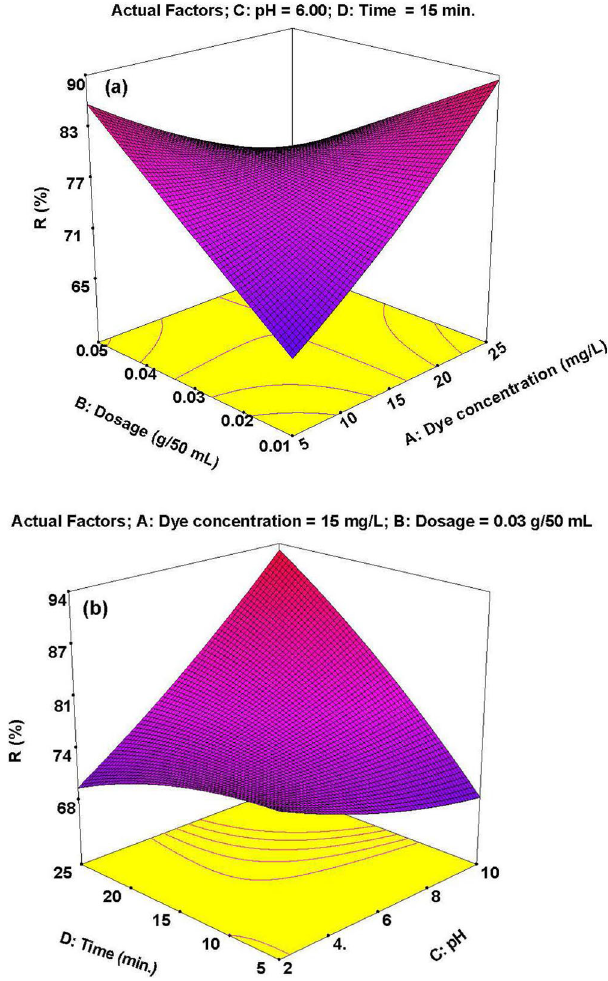
Fig. 5 3D plots of MB photocatalytic degradation interactions. a Photocatalyst dosage vs. Dye concentration. b Irradiation time vs. pH.